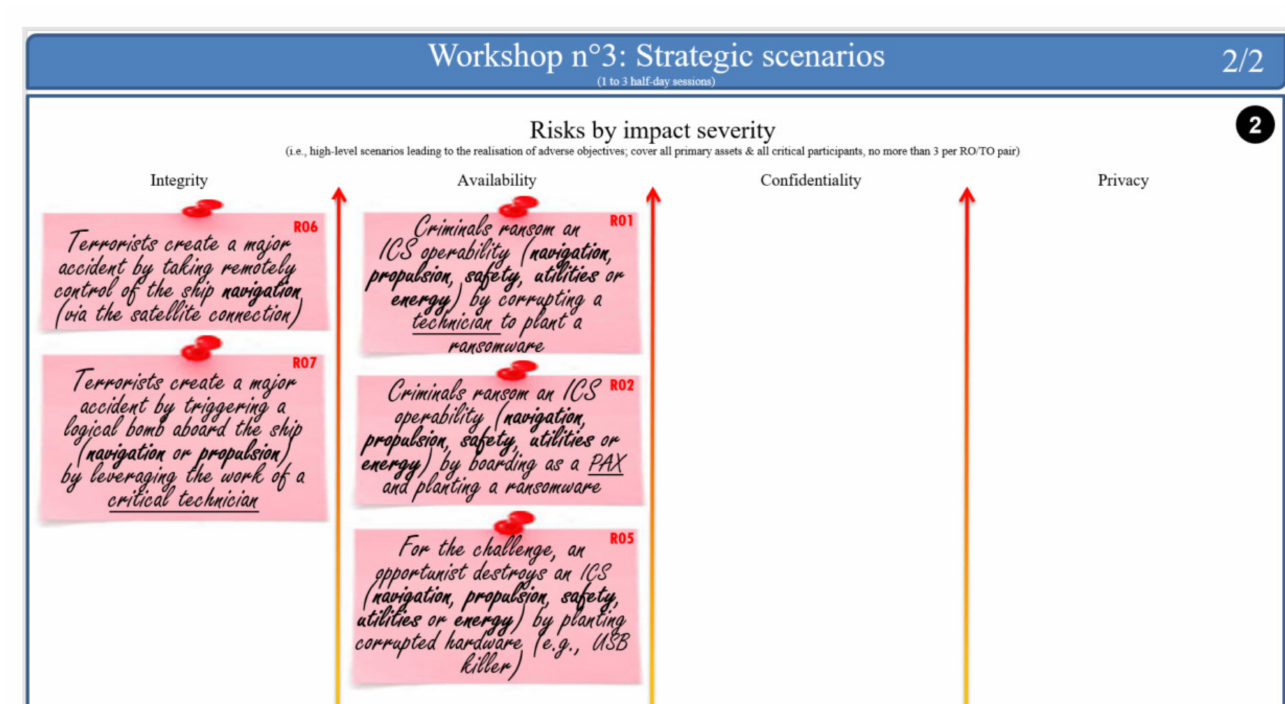
Figure 11. Naval use case—strategic scenarios (textual